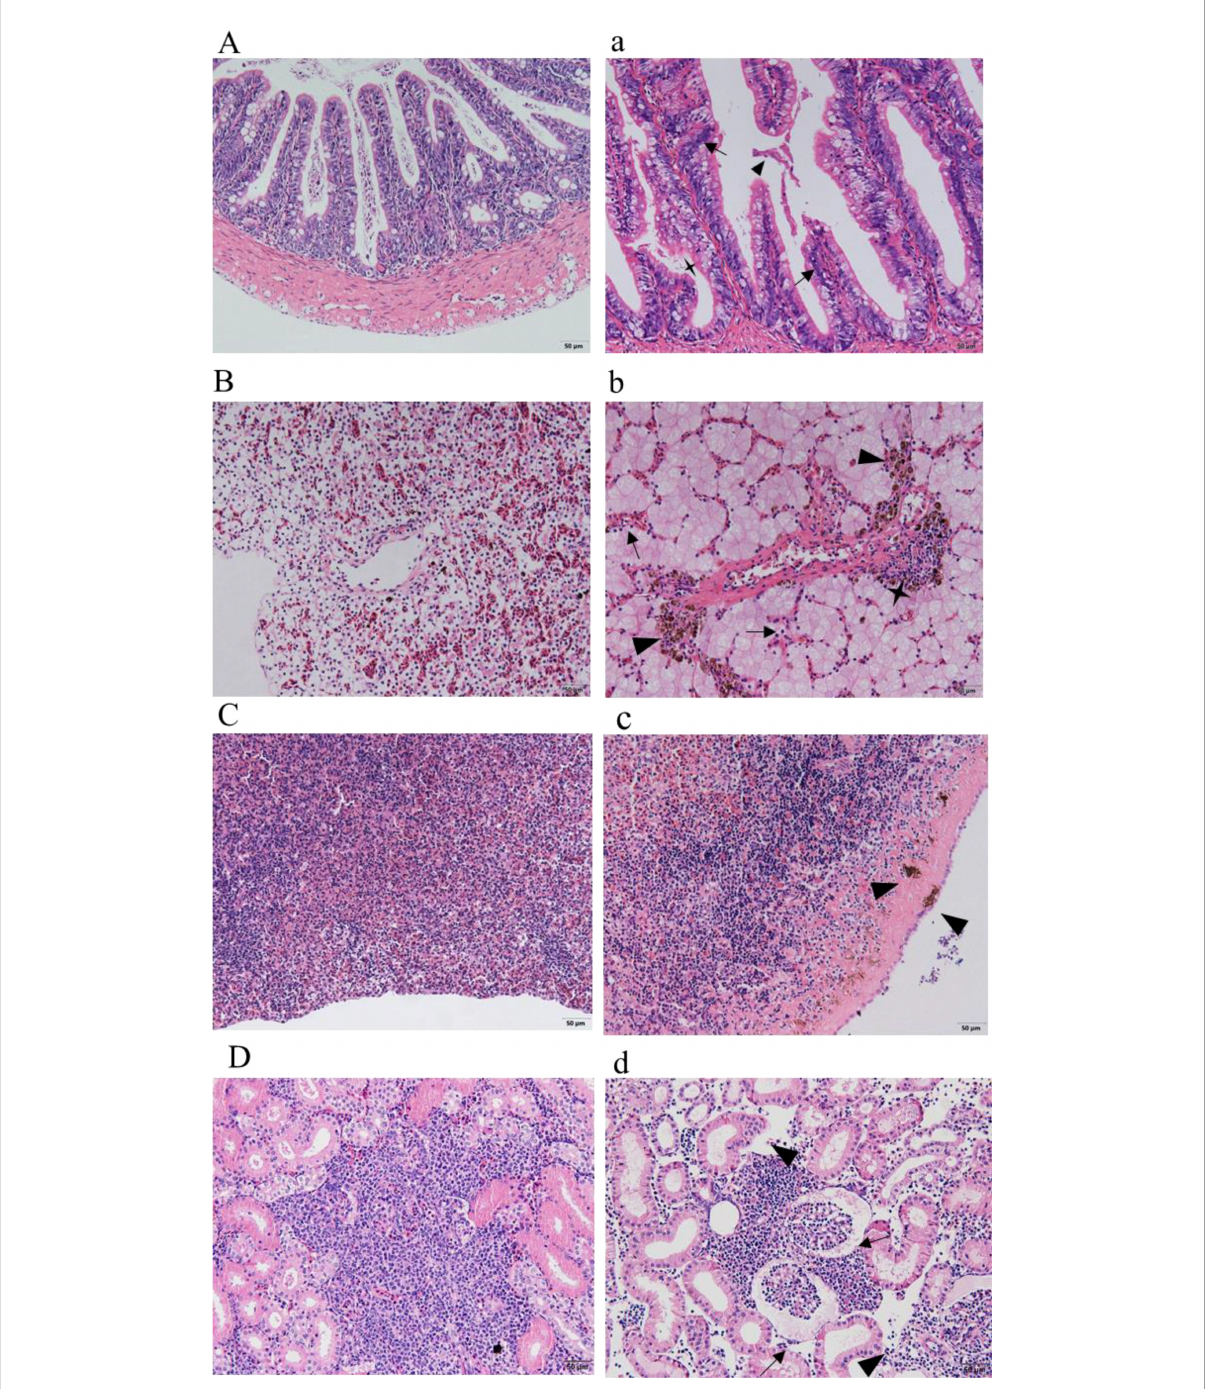
FIGURE 8 Histopathological observation. (A – D) show the intestines, livers, spleens, and kidneys of healthy sturgeons, respectively. (a) Intestinal pathological changes; intestinal epithelial cell hyperplasia (black arrows), shedding of the intestinal mucous membrane (triangles), necrotic (quadrangular). (b) Changes in liver pathology; dilated hepatic sinusoids (black arrows), in fi ltrated in fl ammatory cells (quadrangular), increased number of perivascular melanocyte macrophage centers (triangles). (c) Pathological changes in the spleen; increased numbers of melanocyte macrophage centers (triangles). (d) Kidney pathological changes; swollen renal glomeruli (black arrows), necrosis or even disappearance of interstitial kidney tissue (black arrows). Scale bar: 50 m m, magni fi cation 20× objective